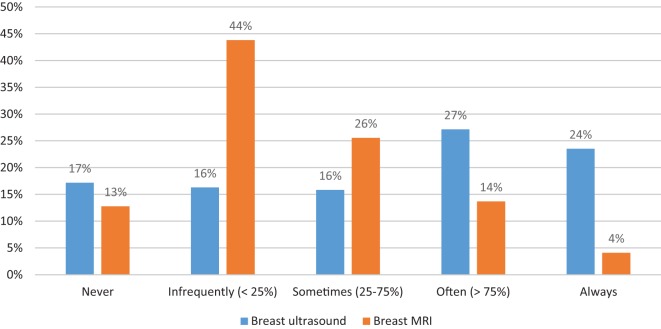
Distribution of additional breast imaging. Proportion of respondents reporting their likelihood of ordering either breast ultrasound (blue bars) or breast MRI (orange bars).